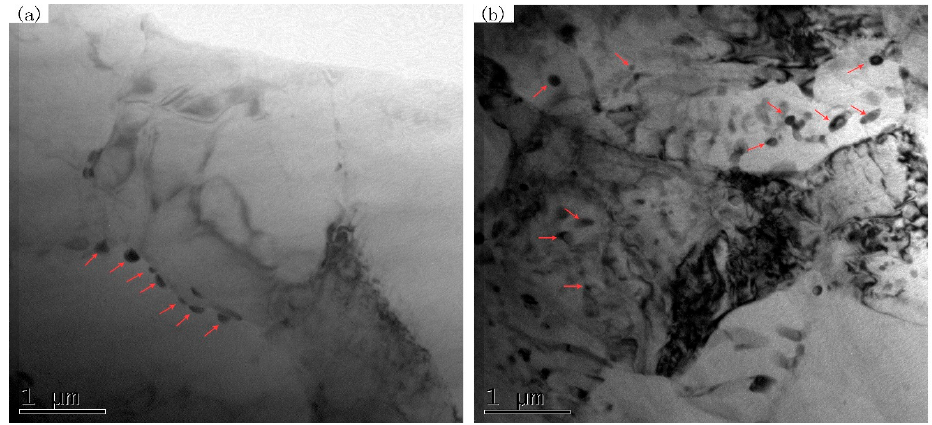
Figure 5. Transmission electron microscopy (TEM) images showing particles as marked by arrows in SZ of ( a ) one-pass and ( b ) two-pass SFSP specimens.